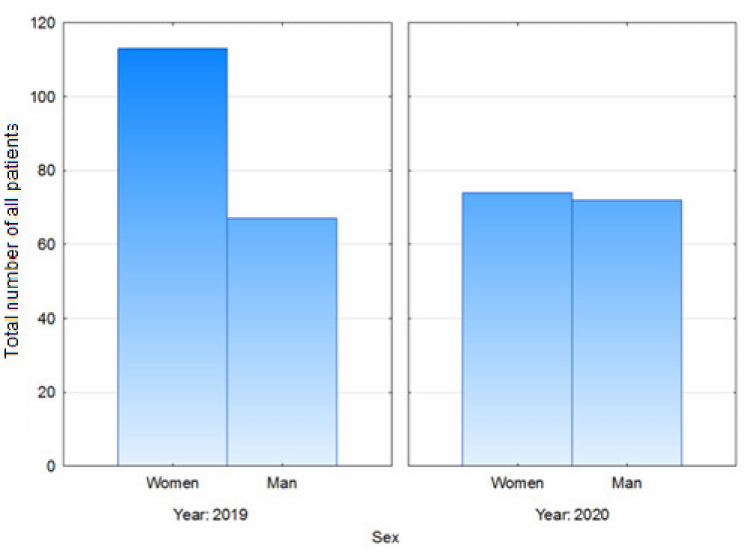
Figure 4. Female to male